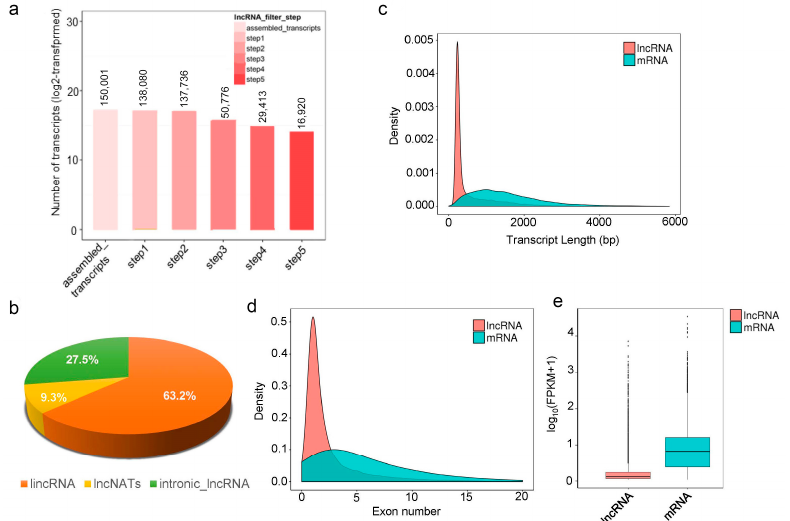
Figure 2. Identification and characteristics of lncRNAs in the seeds of yellowhorn. ( a ) Number of lncRNAs identified in five screening steps. ( b ) Classification and percentage of lncRNAs. ( c ) Transcript length distribution of identified lncRNAs and mRNAs. ( d ) Exon number distribution of identified lncRNAs and mRNAs. ( e ) The overall FPKM value of identified lncRNAs and mRNAs.